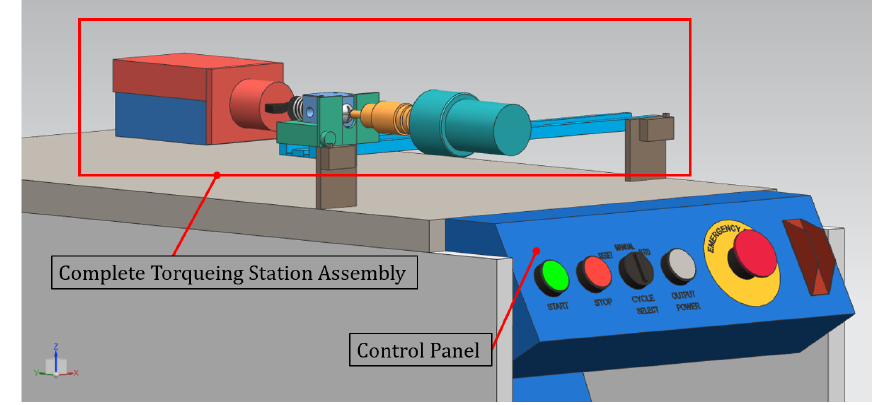
Figure 8. Final assembly of the torquing